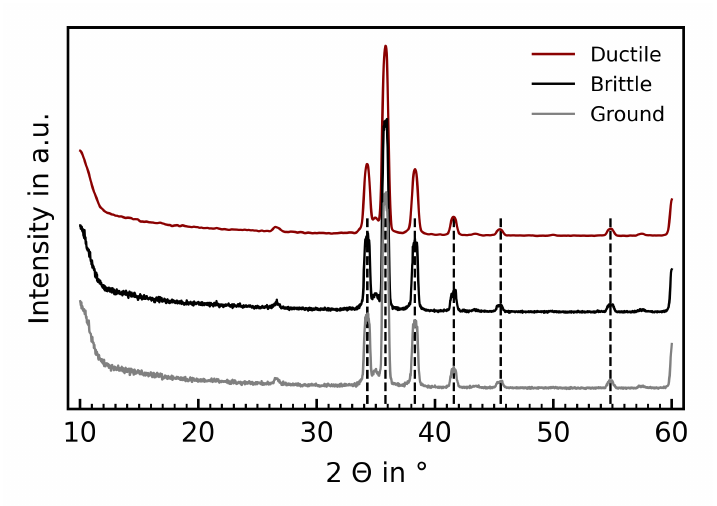
Figure 18. Recorded XRD spectra for the ductile-milled, brittle-milled and diamond ground sample surfaces. The dashed lines show the corresponding 6H structure reflexes (powder diffraction file